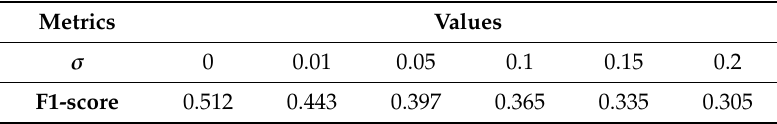
Figure 10. Quantitative comparisons on the average of precision and recall curves for Potsdam (VIS / NIR) dataset at di ff erent noise levels. The Gaussian white noise with a mean of zero is adopted. (VIS/NIR) dataset at different noise levels. The Gaussian white noise with a mean of zero is adopted. A large variance σ indicates great noise intensity. σ indicates great noise intensity. A large variance Table 2. Average of F1-score values with di ff erent noise Table 2. Average of F1-score values with different noise levels.